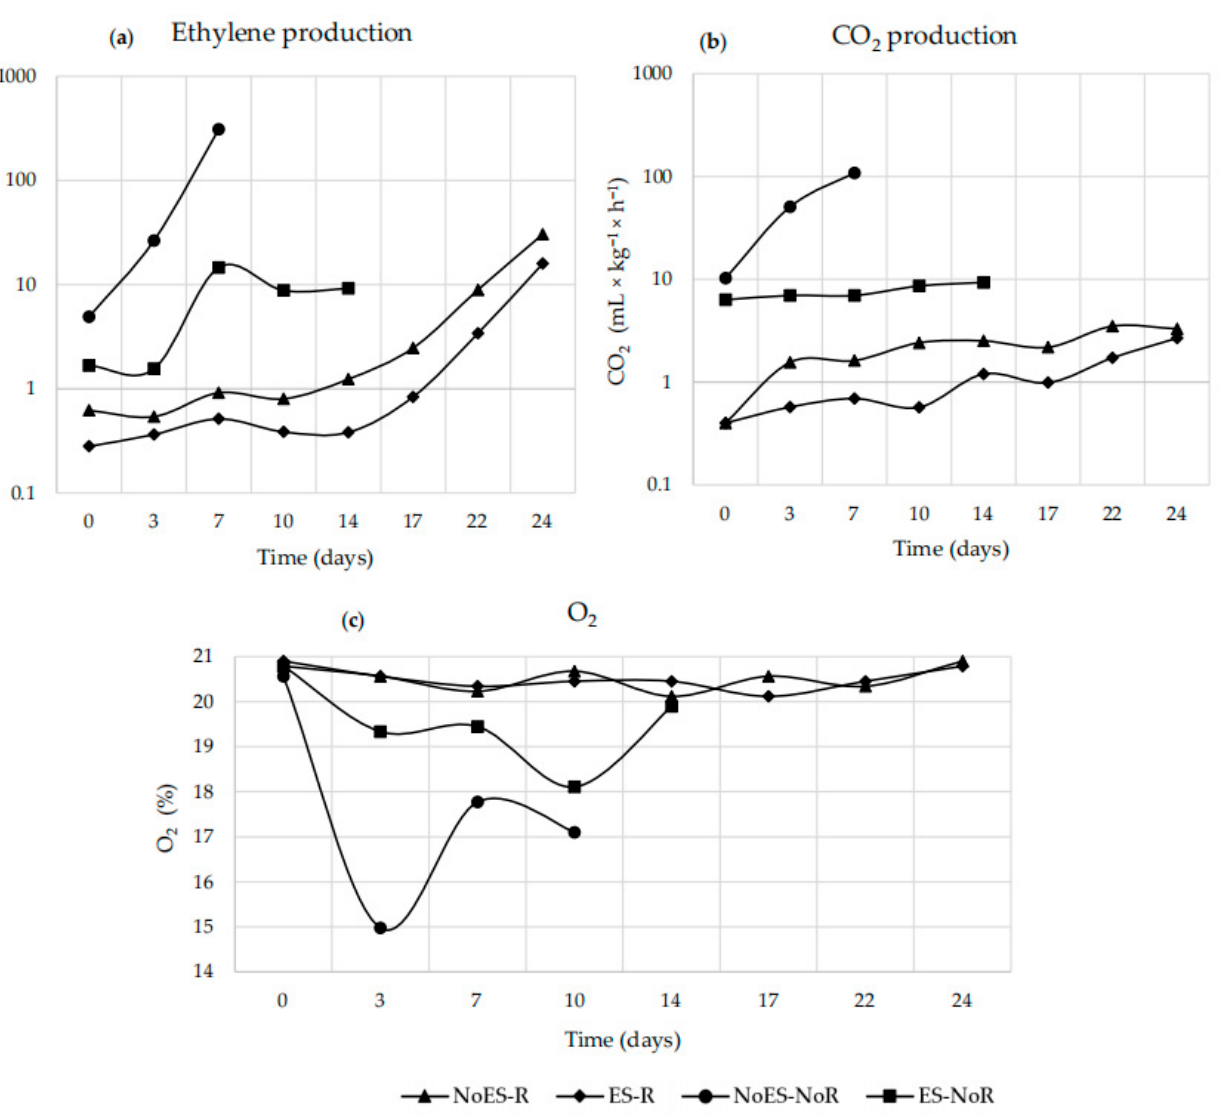
Figure 1. Ethylene ( a ) and CO 2 ( b ) production expressed as mL × kg − 1 × h − 1 and O 2 percentage ( c ) over the storage time in peaches subjected to the different treatments (NoES-R, ES-R, NoES-NoR and ES-NoR). The y -axis in Figure 1a,b corresponding to ethylene and CO 2 production, respectively, are displayed on a base 10 logarithmic scale.